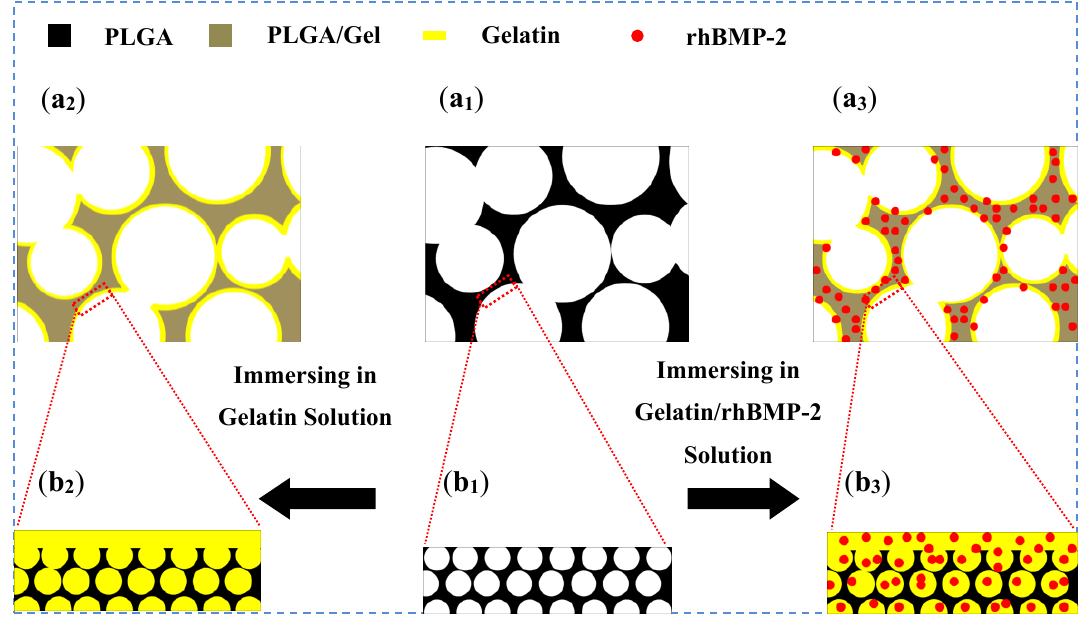
Figure 1. Schematic diagram of surface coating on PLGA scaffold ( a scaffolds coated with gelatin (PLGA/Gel; a (PLGA/Gel/rhBMP-2; a